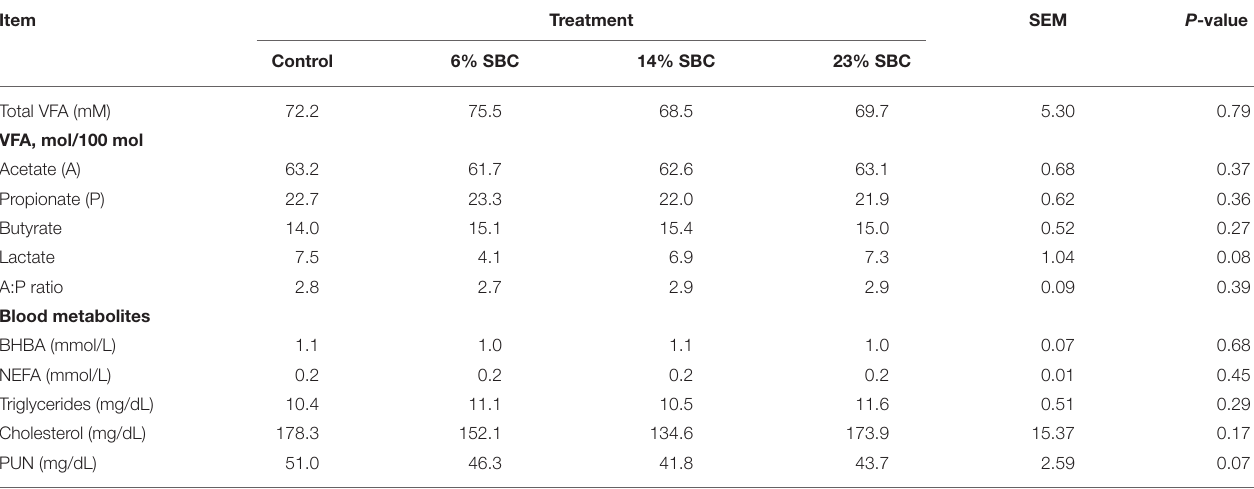
TABLE 3 | Effect of replacing soybean meal (SBM) with soybean cake (SBC) on volatile fatty acids (VFA) and blood metabolites in dairy cattle.